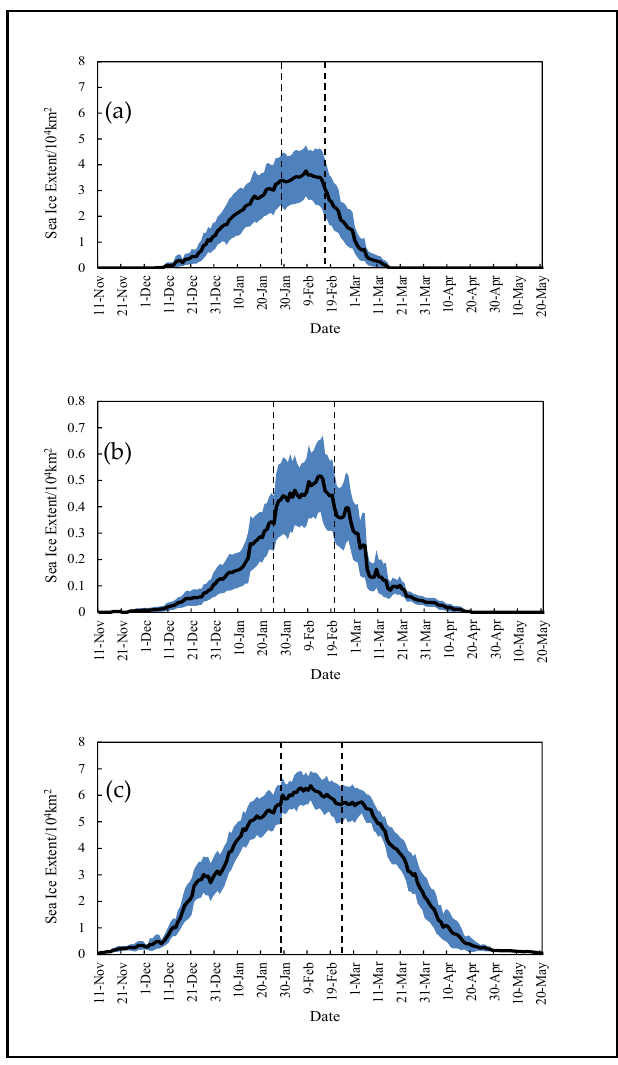
Figure 4. Daily mean sea ice extent (black, solid line) and standard deviation (blue area) in the Bohai Sea and Yellow Sea ( a ), Peter the Great Bay ( b ) and the northern Sea of Japan ( c ) from 2005 to 2021. Table 2. Trends in the total sea ice extent in the marginal seas of East Asia (unit: 10 7 km 2 /10 yr). Dec